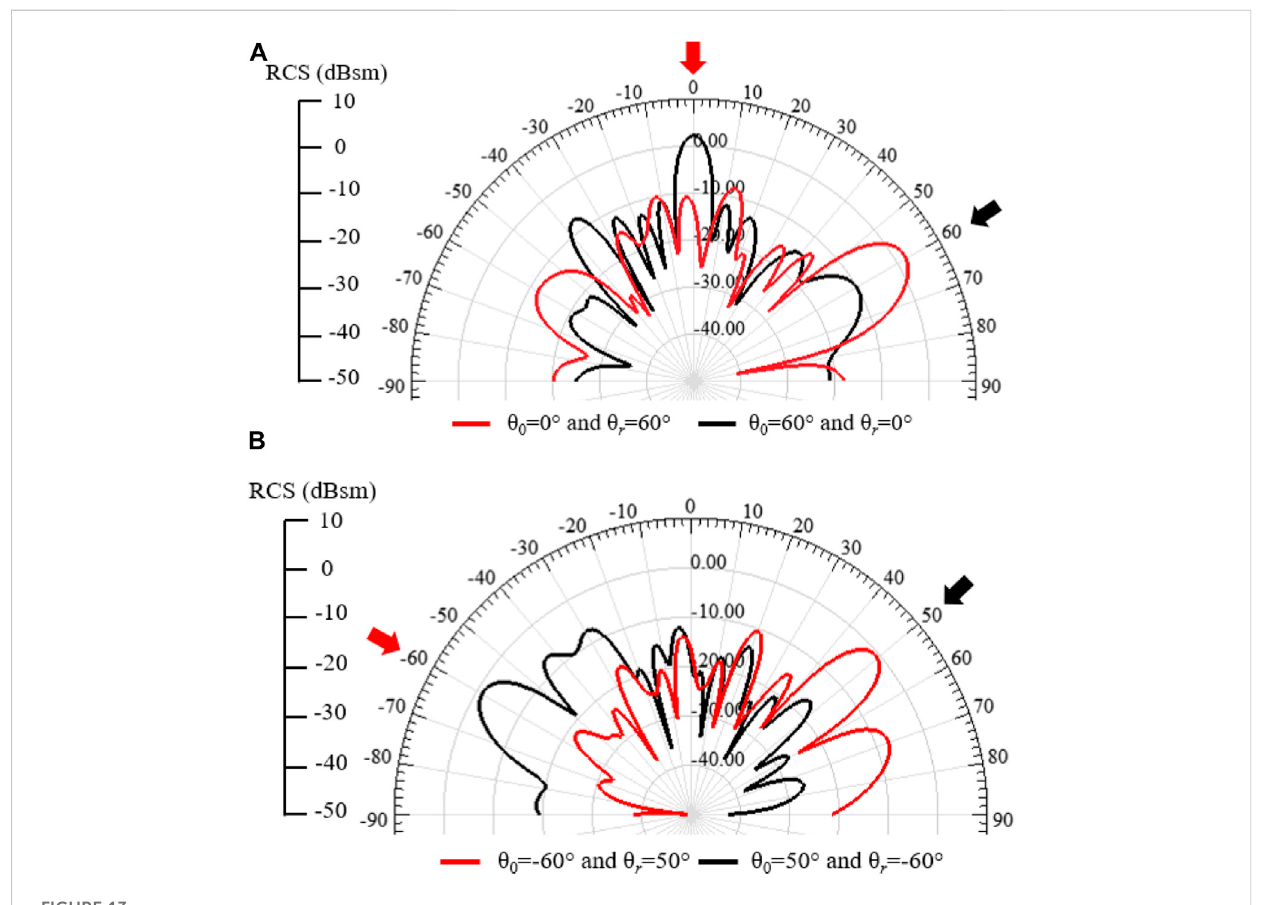
FIGURE 13 Simulated RIS angle reciprocity response. (A) Normal plane wave. (B) Oblique plane wave.